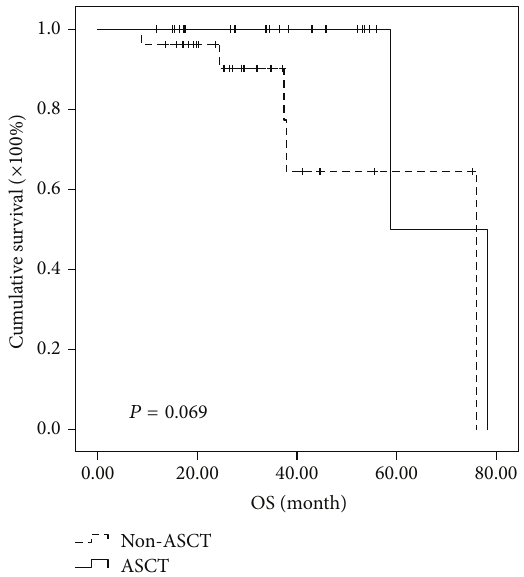
Figure 7: Comparison of PFS in the patients of ASCT group and non-ASCT group in the low-risk subgroup. The median PFS was prolonged 17.2 months in ASCT group (34.8 versus 17.6 months, 𝑃 = 0.012 ).